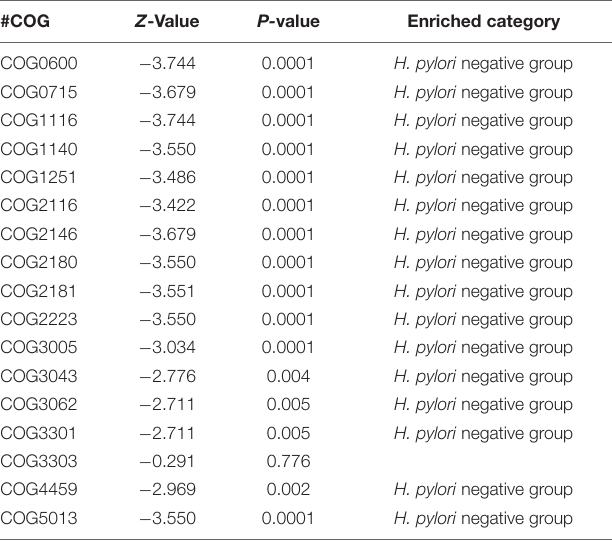
TABLE 4 | The selected clusters of orthologous groups (COG) and Kyoto Encyclopedia of Genes and Genome orthology (KO) functions predicted with the whole bacterial